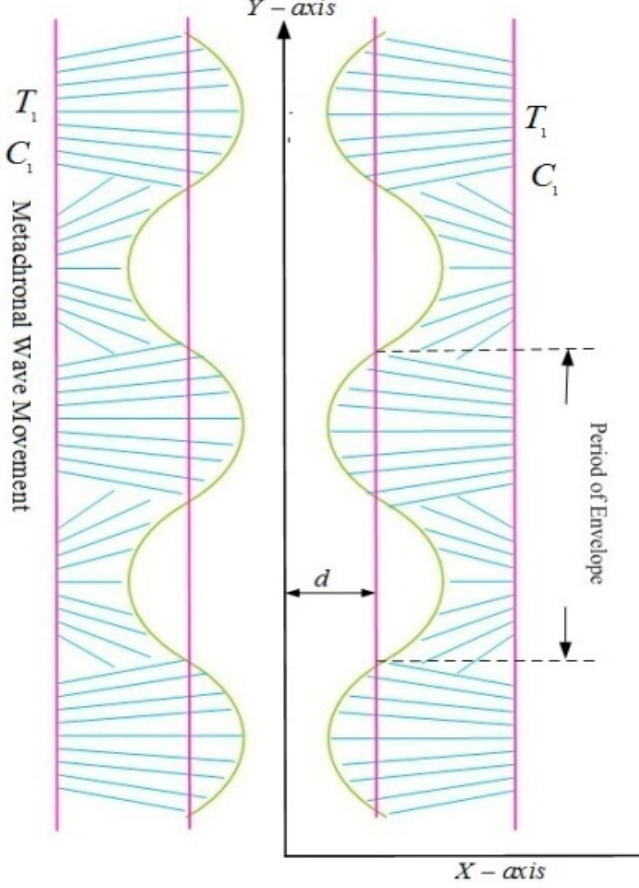
Figure 1. A geometrical diagram of a ciliated channel with a metachronal wave system.